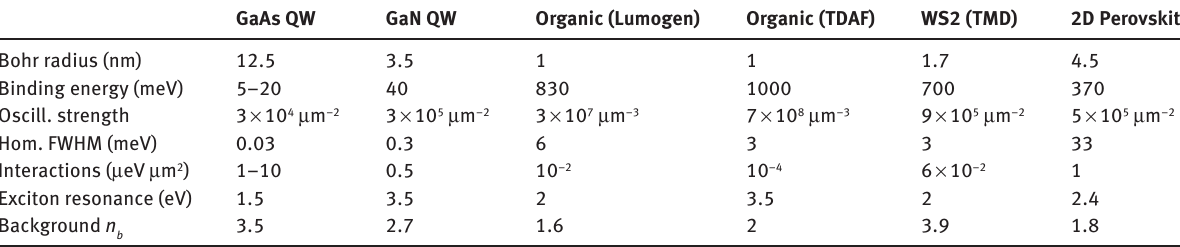
Table 1: Excitonic properties in inorganic, organic, and hybrid semiconductors. GaAs QW GaN